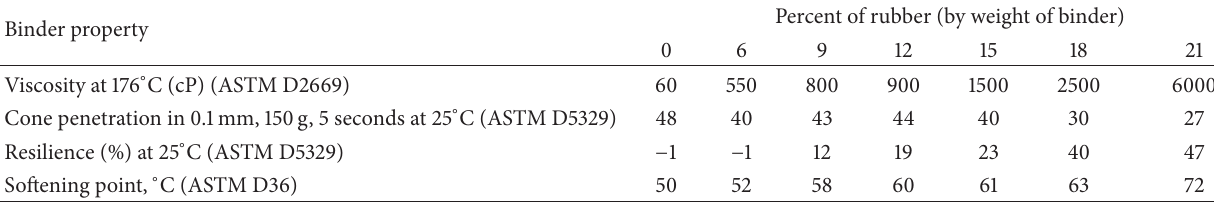
Softening point, ∘ C (ASTM